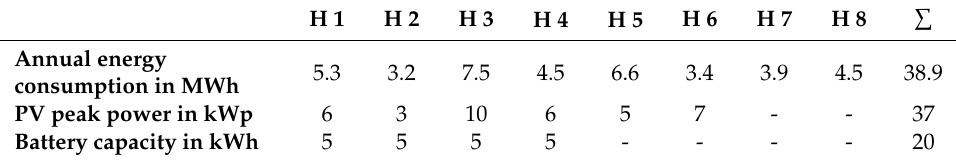
Table 4. Characteristics of the households in the investigated neighborhood (H: household). H